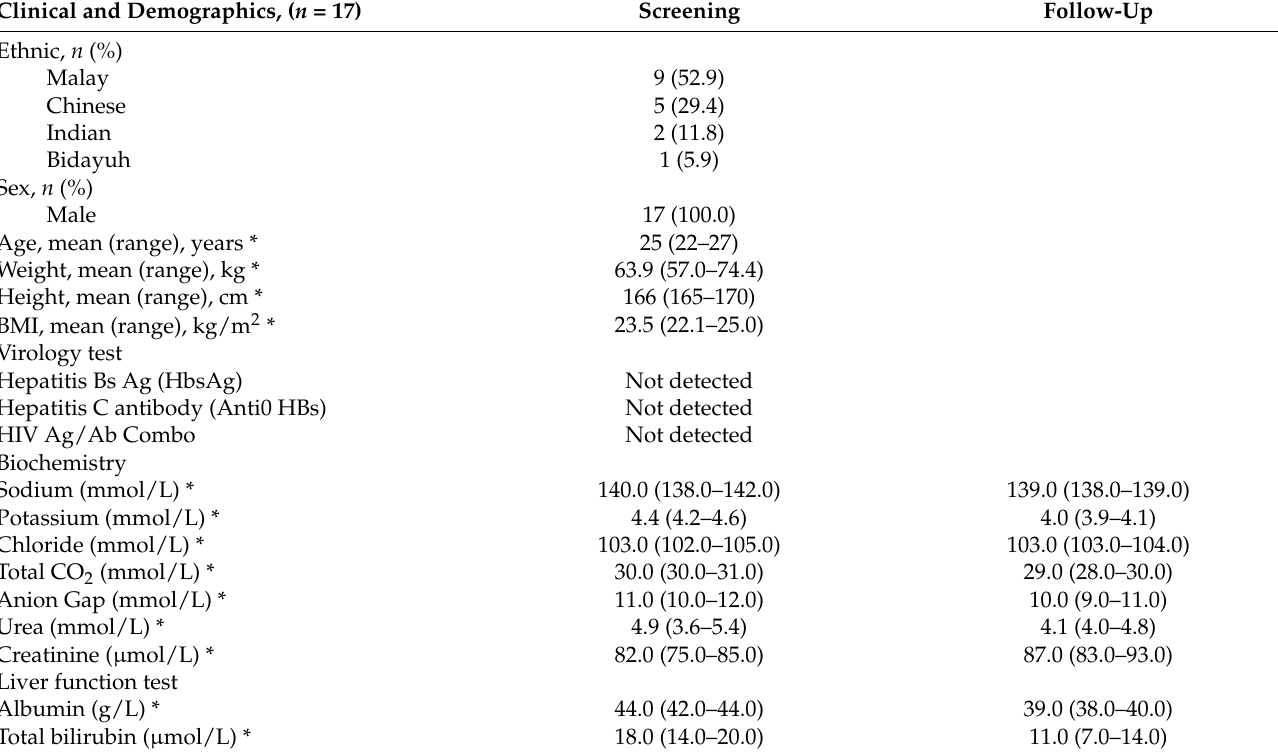
Table 1. Demographic and clinical characteristics of the study